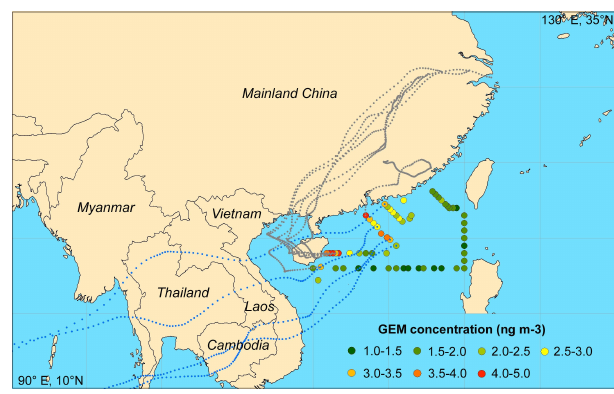
Figure 4. Spatial distribution of GEM concentrations and back- wards trajectories in the marine boundary layer of the South China Sea (Fu et al.,